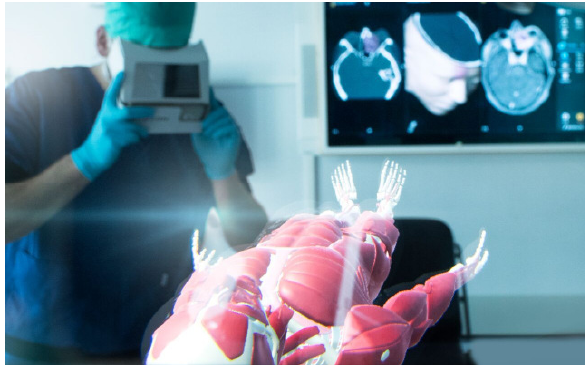
Figure 4. Use of AR headset in the medical-educational